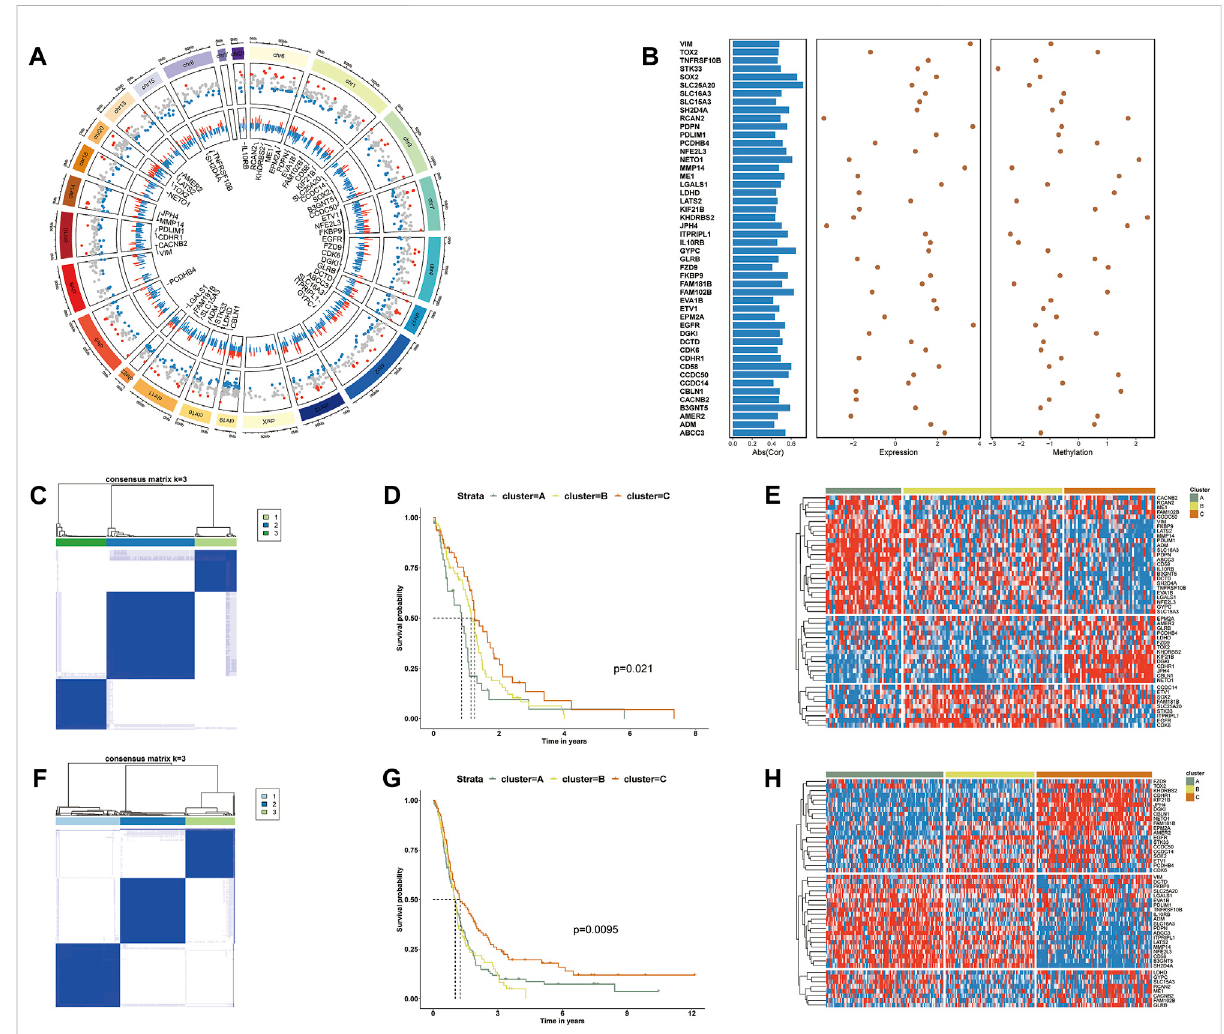
FIGURE 1 (A) The Screening process of PCGI methylation-driven genes. The fi rst circle shows the chromosomal location and ordering information. The second circle represents the distribution of differential methylation genes. Red points represent hypermethylation, and blue ones represent hypomethylation relative to normal samples. The third circle shows the relationship between methylation and gene expression. Blue and red bars represent values with negative and positive correlations, respectively. (B) Overview of 48 PCGI methylation-driven genes. The fi rst column shows the absolute values of the correlation coef fi cients between DNA methylation and expression level. The second and third columns show the fold change of the expression and methylation level. (C) Consensus cluster for GBM patients of TCGA based on PCGI methylation-driven genes. (D) Kaplan – Meier survival analysis for TCGA sample clusters. (E) Hierarchically clustered heatmap for the expression of PCGI methylation-driven genes across clusters in TCGA. (F) Consensus cluster for GBM patients of CGGA based on PCGI methylation-driven genes. (G) Kaplan – Meier